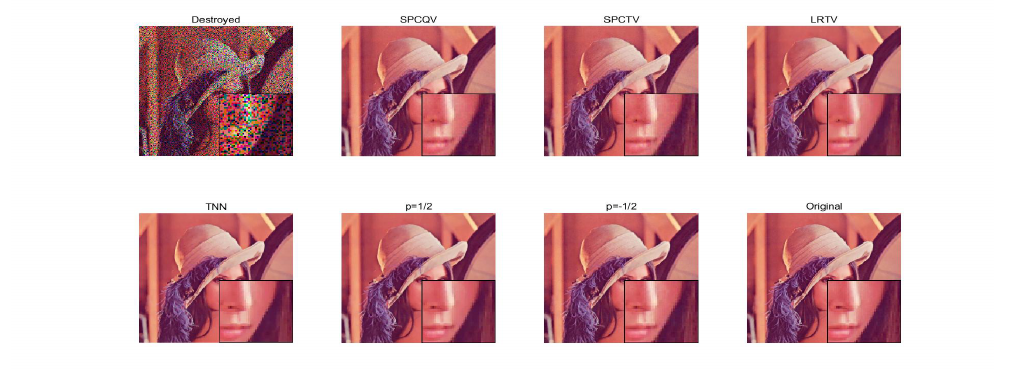
Figure 4. Comparison of damaged image restoration under the 30% missing rate and Gaussian noise N ( 0,10 )